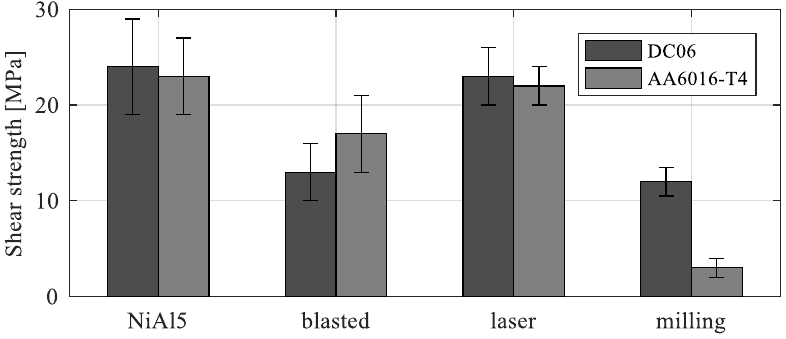
Figure 7. Tensile shear strength of metal/FRP specimen joined by die heating.